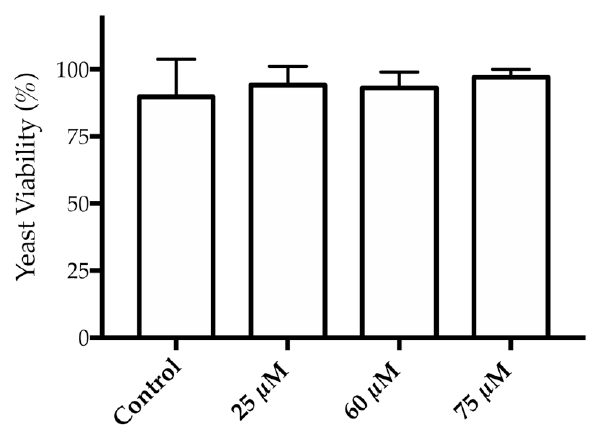
Figure 5. Yeast viability (%) after 4 h of incubation of HAOA-coated GNPs at 25, 60 and 75 µ M (mean value ± S.D., n = 4).